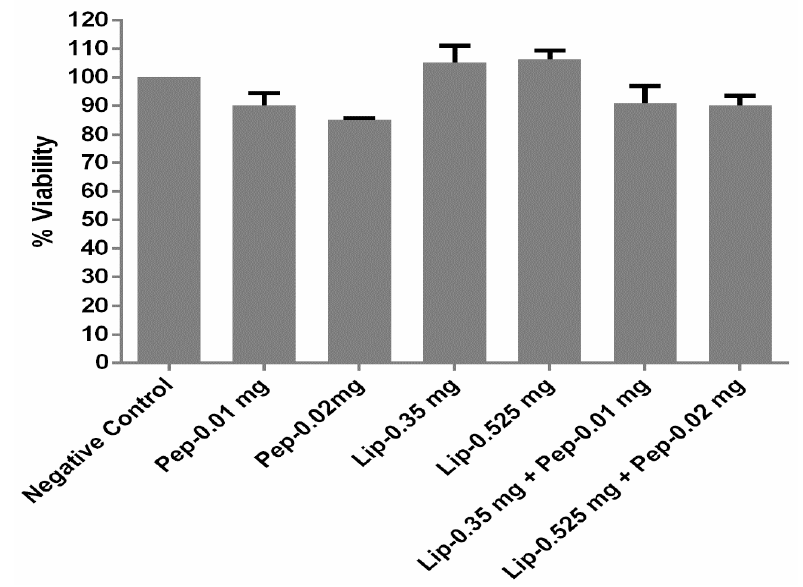
Figure 4. Toxicity profiling of peptide RF-482, liposomes, and RF-482-loaded liposomes presented through cell viability count, performed using the 3-(4,5-dimethylthiazol-2-yl)-2,5-diphenyltetrazolium bromide (MTT) assay (72 h, n = 3 ± SD).